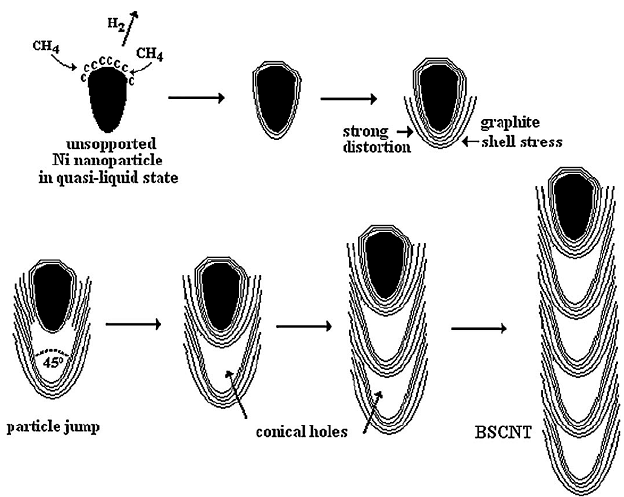
Figure 5. Formation mechanism of bamboo-like carbon nanotubes (reprinted with permission from Ref. [57], copyright 2011 Elsevier).